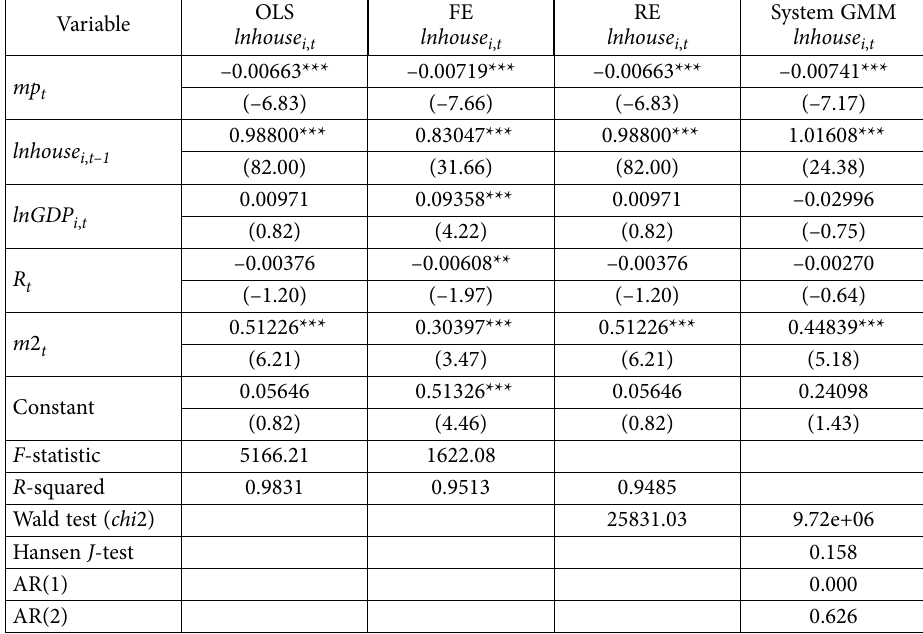
Table 5. The impact of macroprudential policies on the real estate